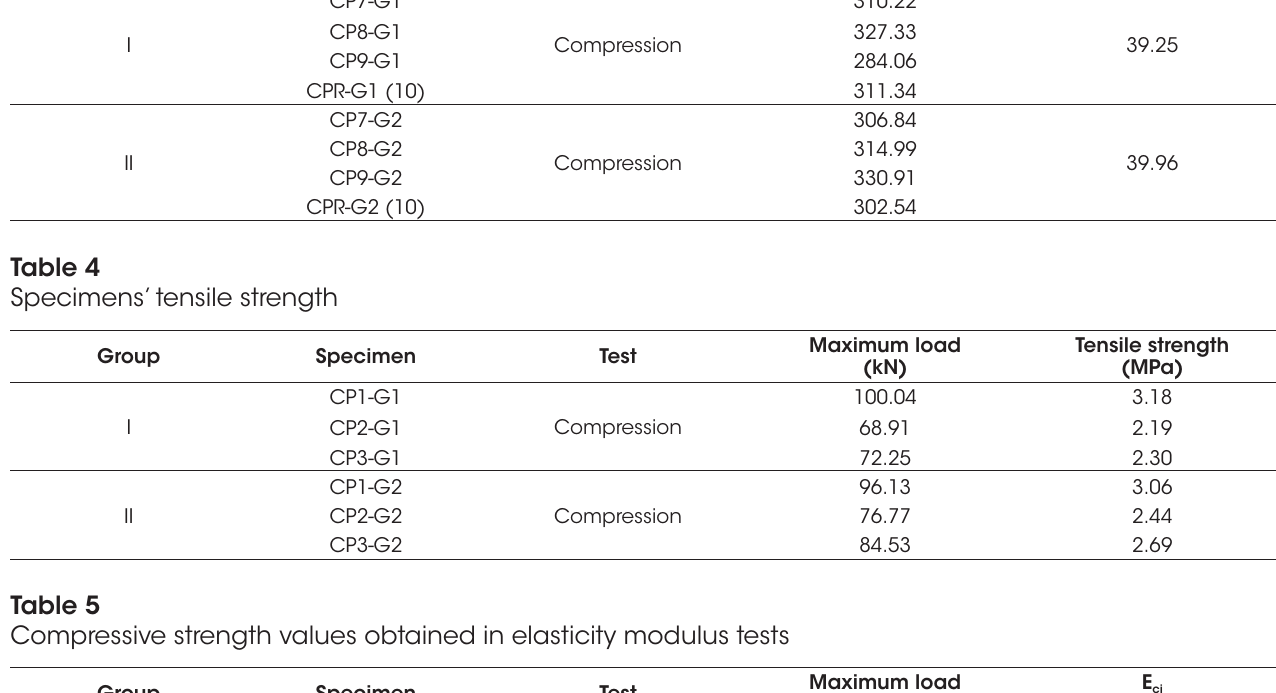
Concrete compressive strength Group